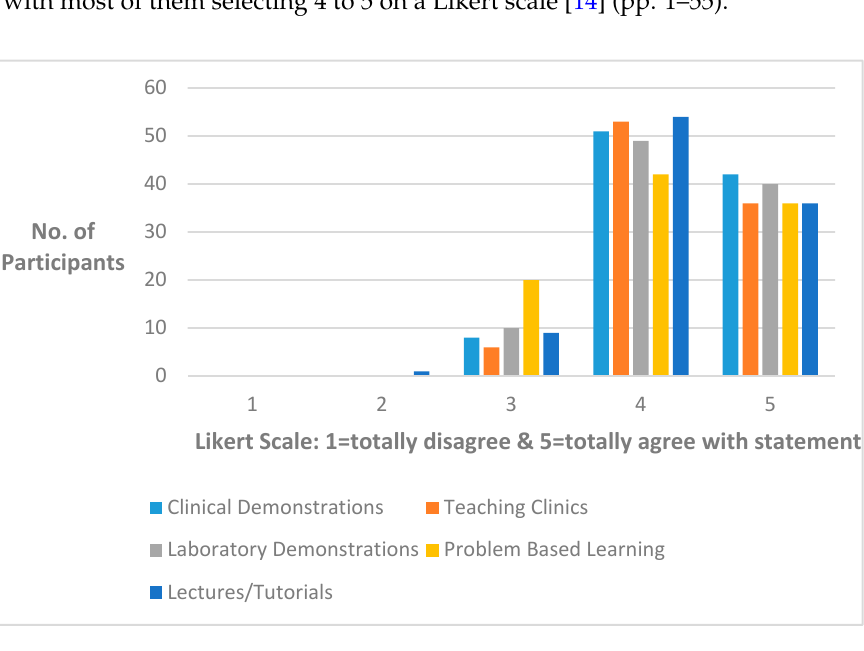
Figure 3. Preferred teaching method of the participants, following the master’s degree in restorative dentistry, in response to the statement ‘Which of the following teaching methods do you prefer?’.